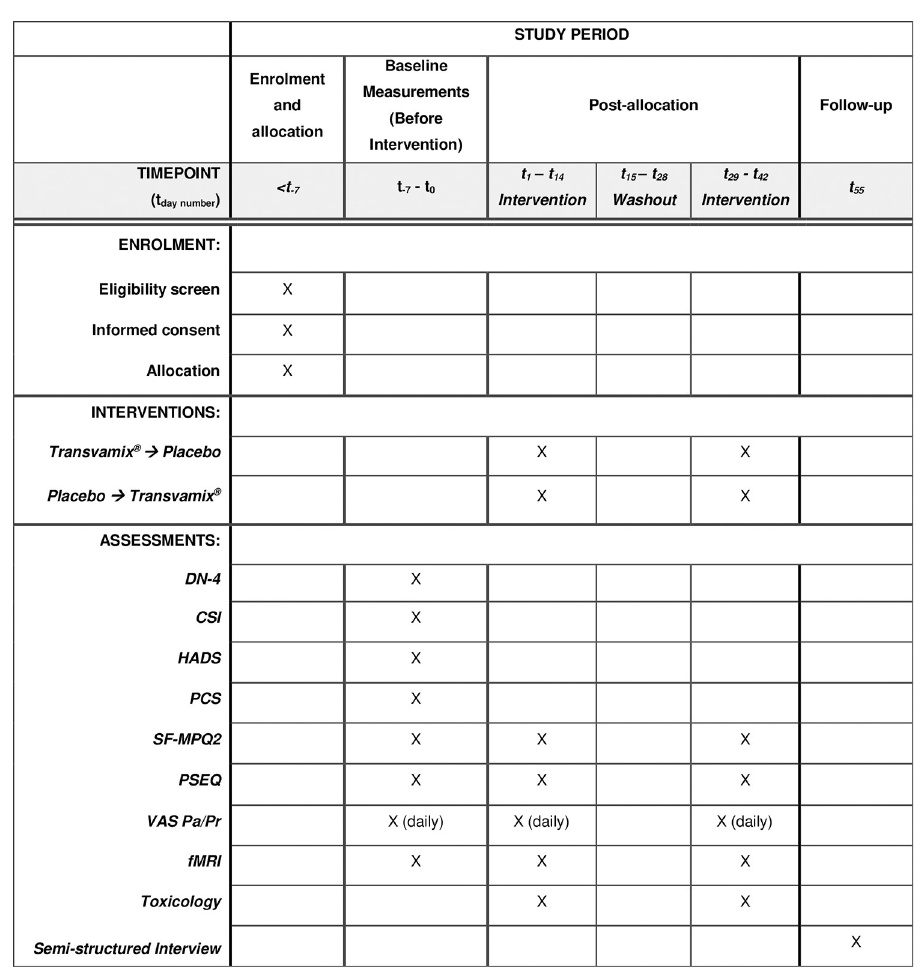
Fig 1. Schedule of enrolment, interventions, and assessments (SPIRIT figure). Participation duration: 64 days, or 9 weeks and 1 day. Duration of participant exposure to interventions: 14 days (placebo), 14 days (Transvamix 1 ). DN-4: douleur neuropathique 4, CSI: central sensitization inventory, PCS: pain catastrophizing scale, SF-MPQ2: short form McGill pain questionnaire 2, PSEQ: pain self-efficacy questionnaire, VAS Pa/Pr: visual analogue scale pain/pruritus, fMRI: functional magnetic resonance